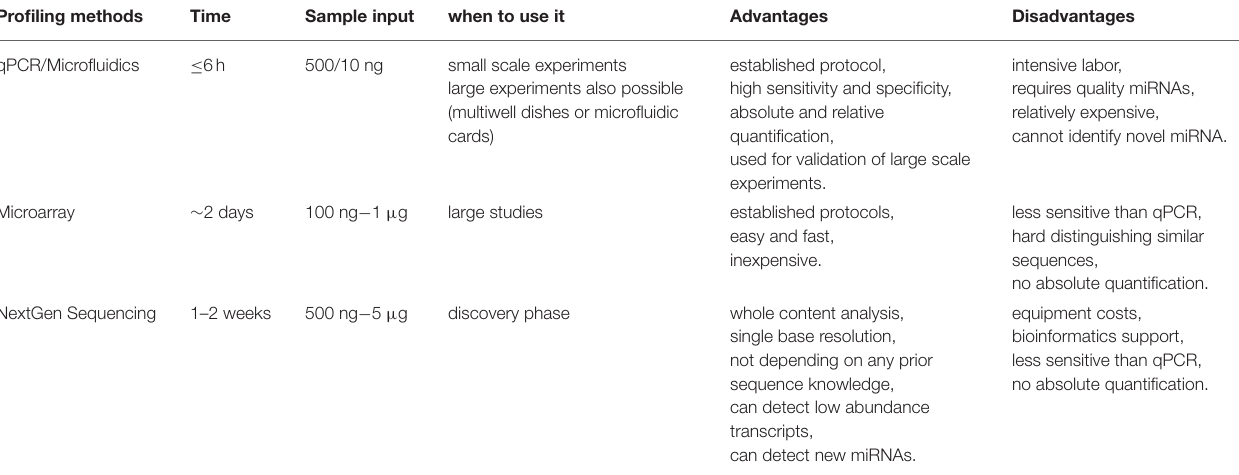
TABLE 4 | Advantages and disadvantages of the main microRNA profiling